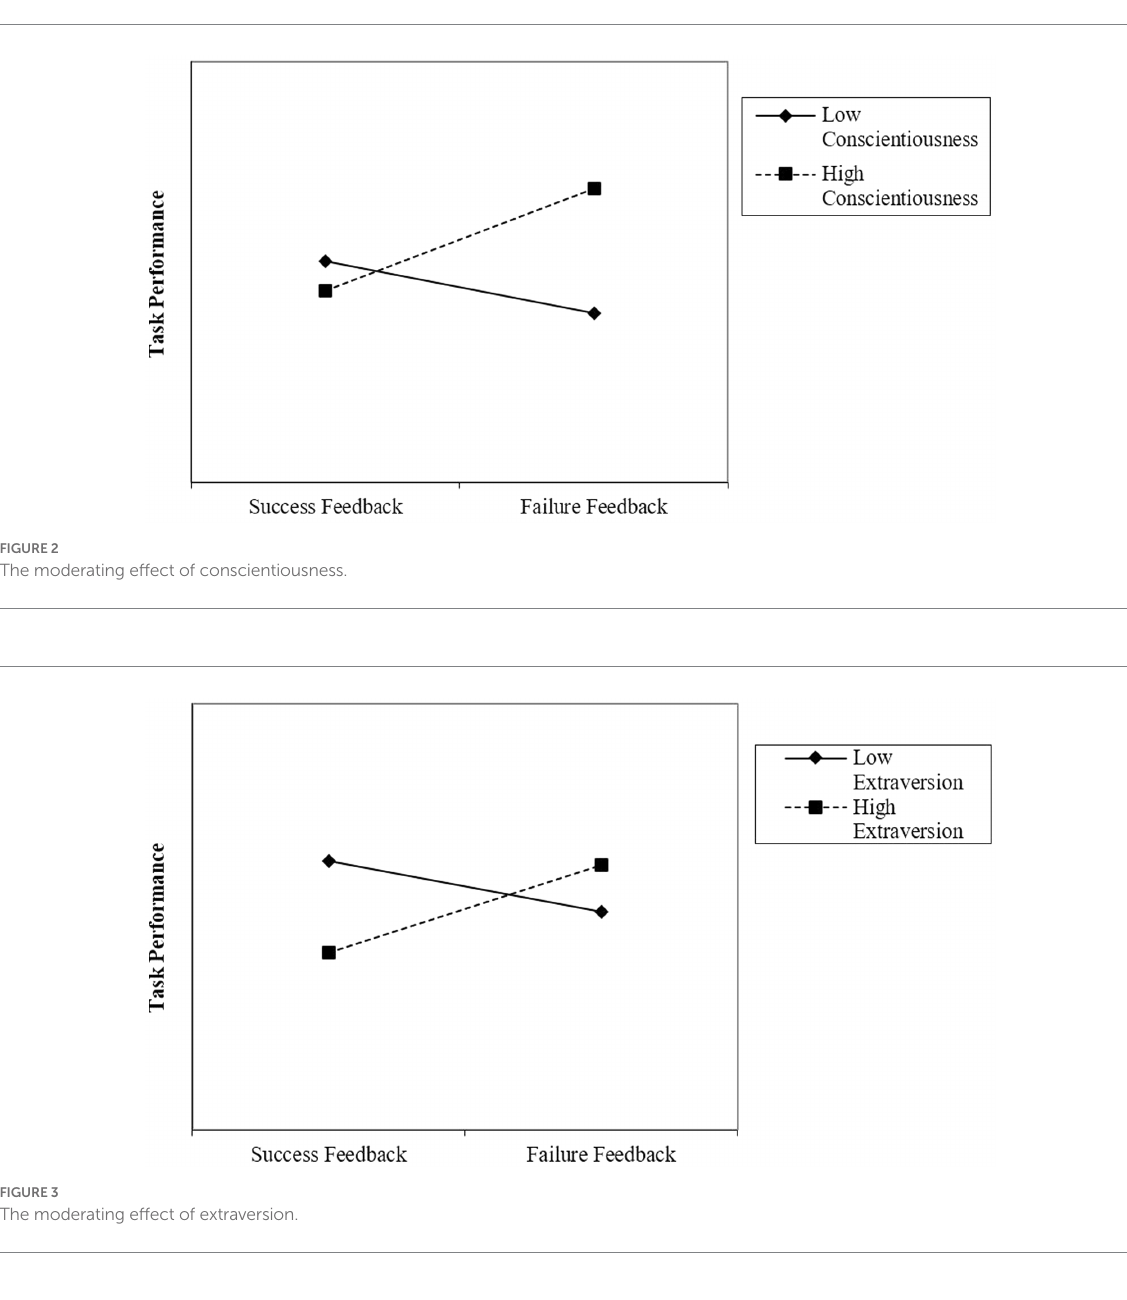
FIGURE 3 The moderating effect of